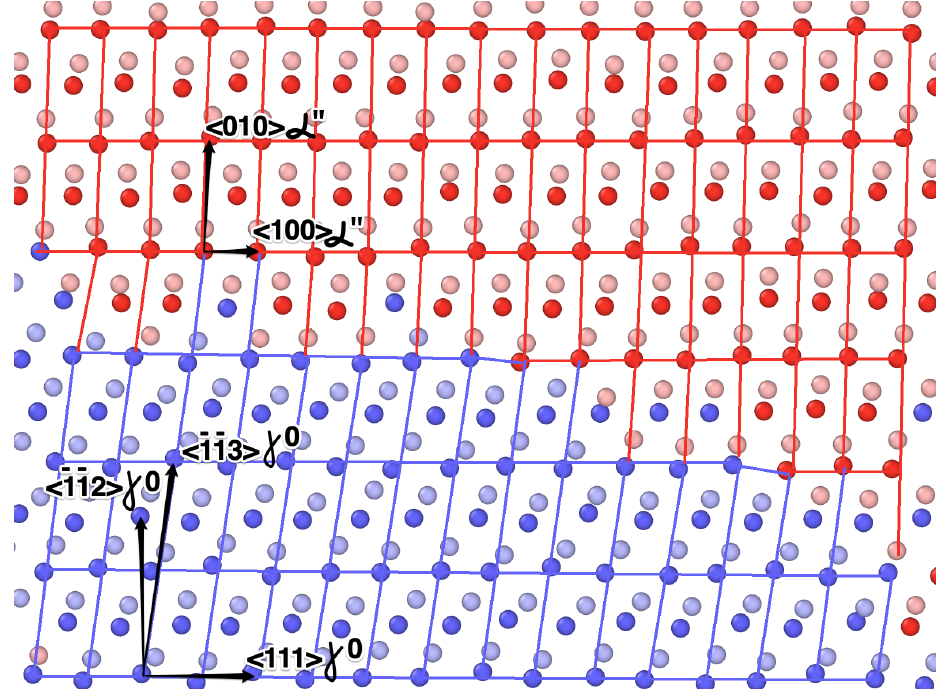
Figure 7. The formed boundary between two phases for the deformation (cid:101) x = 1.3 % (atoms in the z = 0 plane are shown in dark color and atoms in the z = 0.5 c α (cid:48)(cid:48) plane in light color): red atoms correspond to the α (cid:48)(cid:48) -phase and blue atoms to the γ 0